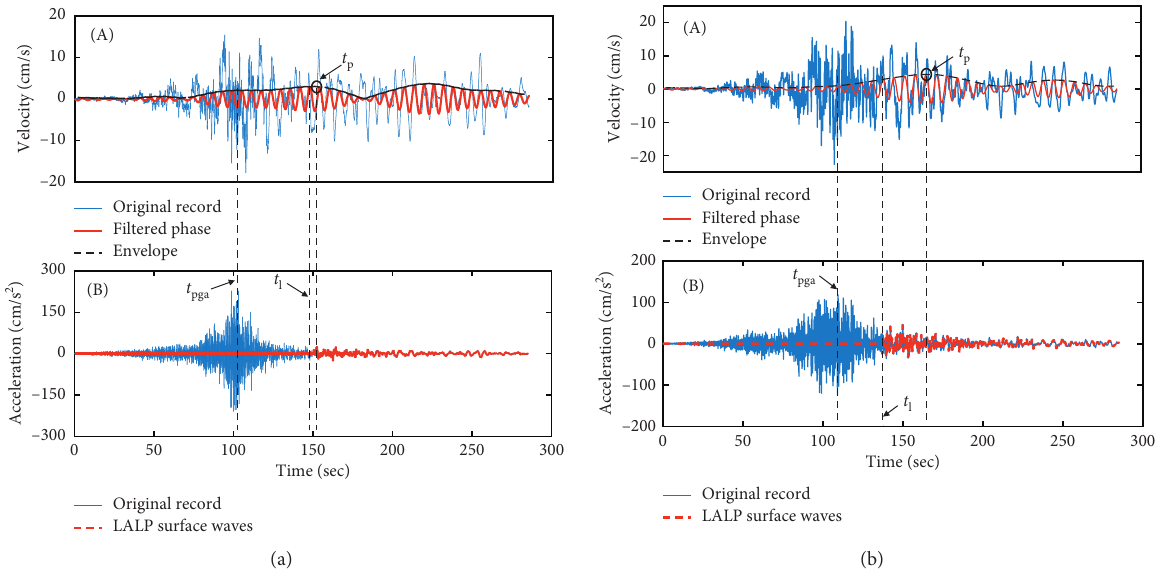
Figure 2: Illustration of determination of long-period components for (a) CHB002EW and (b)